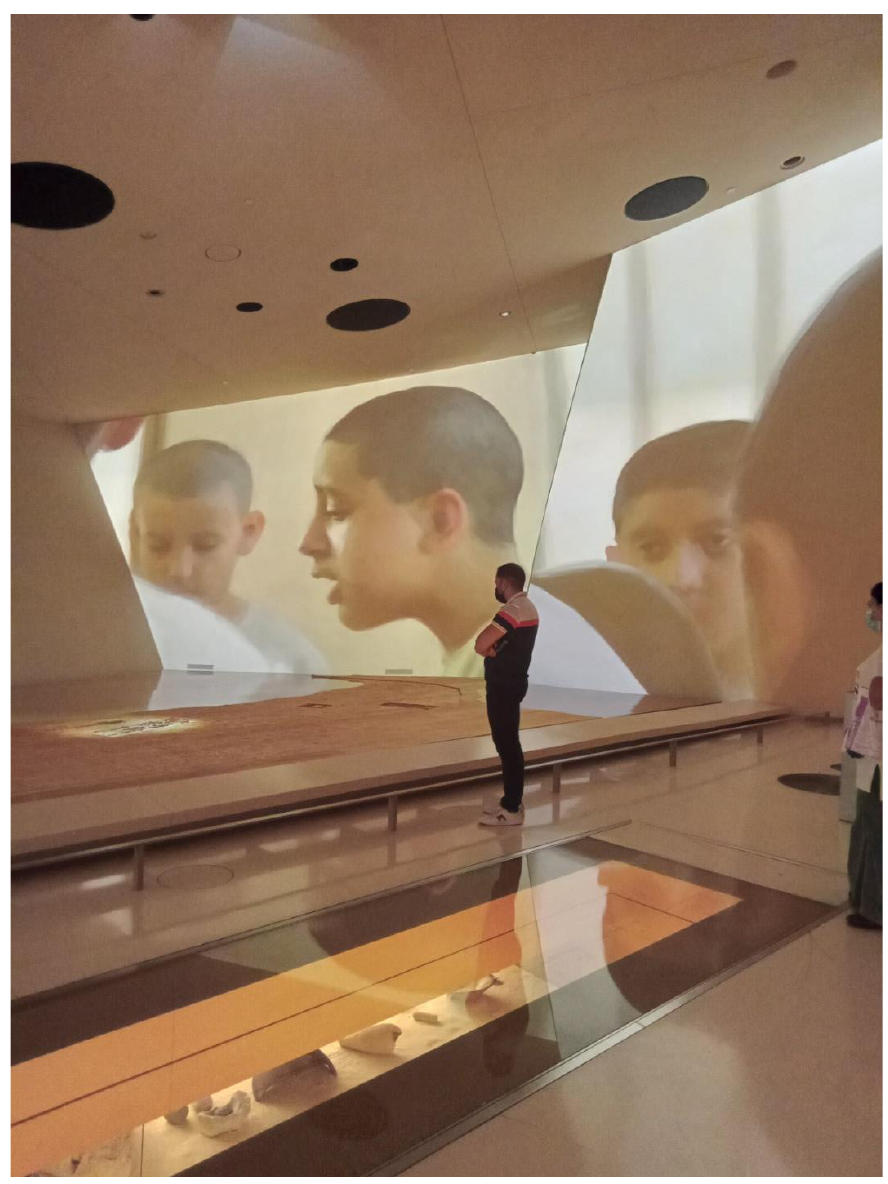
Figure 24. Youngsters reciting the Qur’an, National Museum of Qatar, Doha. Photo of the author.